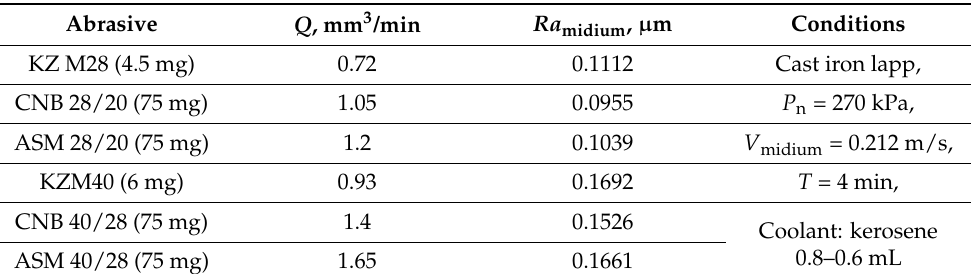
Table 2. Influence of the type and grain size of the abrasive material on the productivity and roughness of the lapped surface.